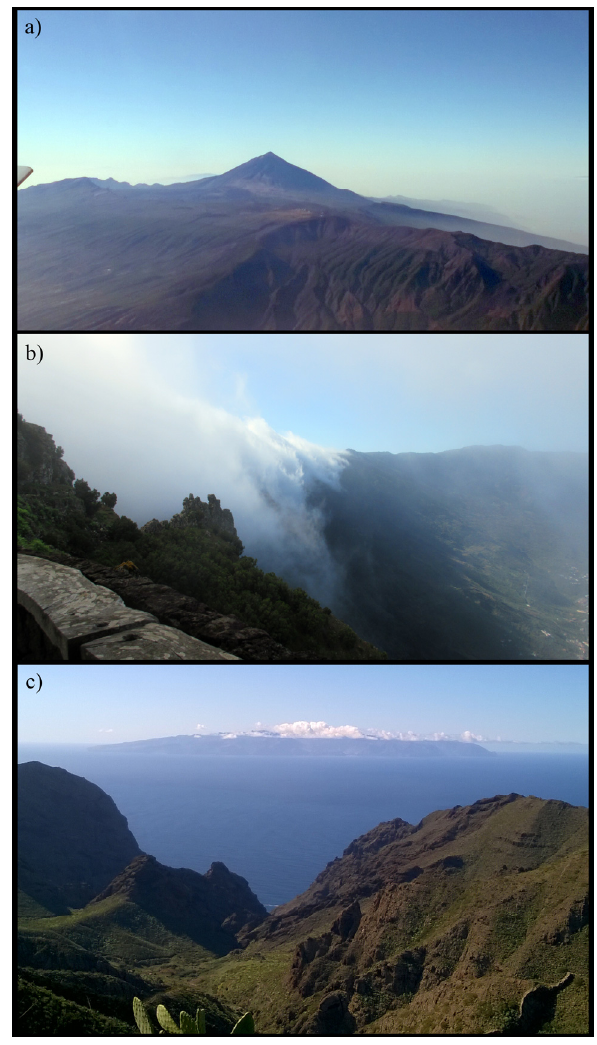
Figure 8. Typical cloud patterns on the Canary Islands. a) Mount Teide with clouds in the northern valleys of Teneriffe; b) Clouds dissolve when downwelling into the El Golfo basin on El Hierro: c) Sea of clouds around La Gomera seen from Tenerife; © Benjamin Bechtel, all rights